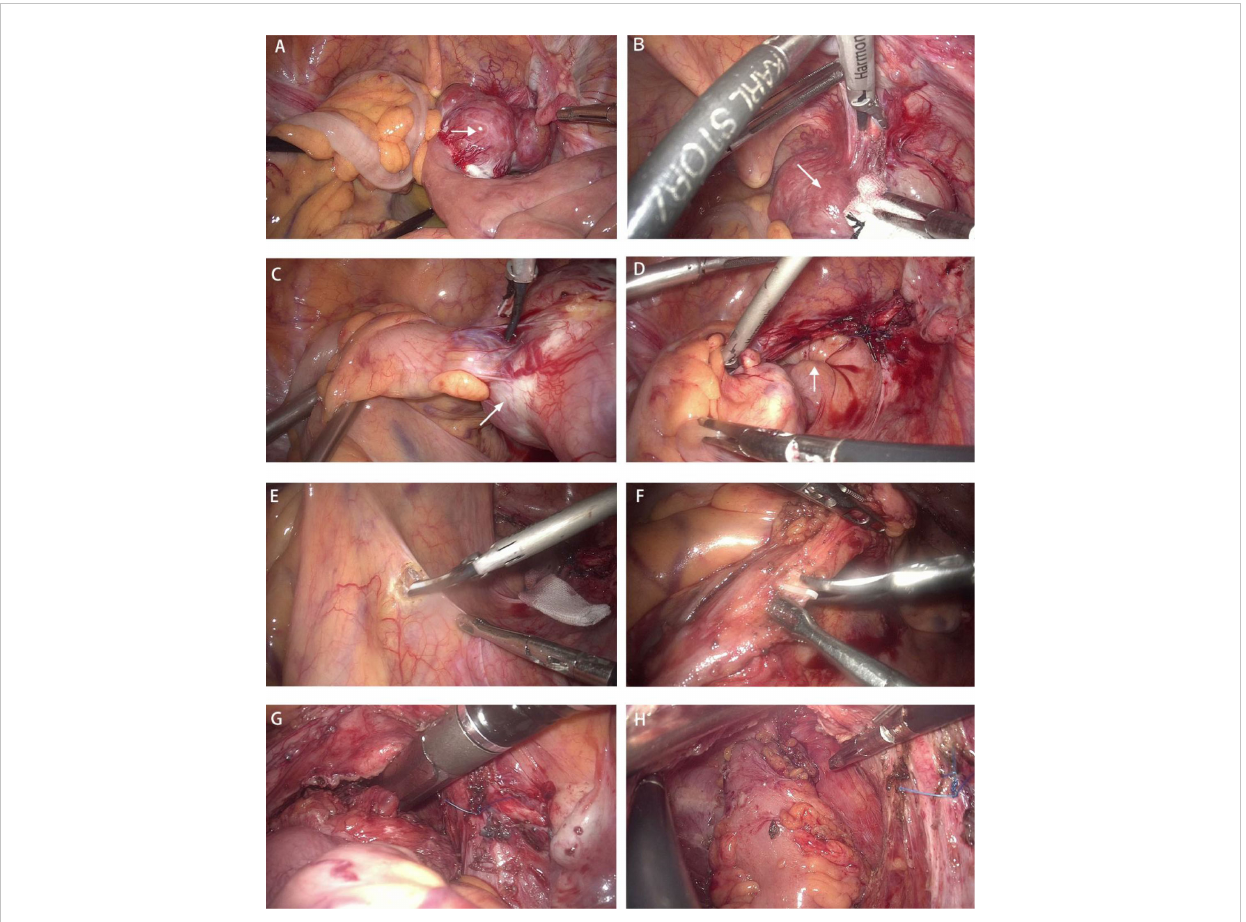
FIGURE 2 Surgical procedure. (A) A small intestinal mass with a rich blood supply was adherent to the pelvic cavity(white arrow). (B, C) The adhesion between the small bowel tumor(white arrow) and the pelvic cavity was loosened. (D) A distinct depression was visible in the anterior wall of the rectum, which was the location of the rectal lesion (white arrow). (E, F) The roots of the interior mesenteric artery (IMA) were dissected under laparoscopy, and the central lymph nodes were cleared. (G) The rectum was excised with a 60-mm linear-stapler (one fi ring) 2 cm below the tumor. (H) End-to-end anastomosis of the rectal stump and sigmoid colon was